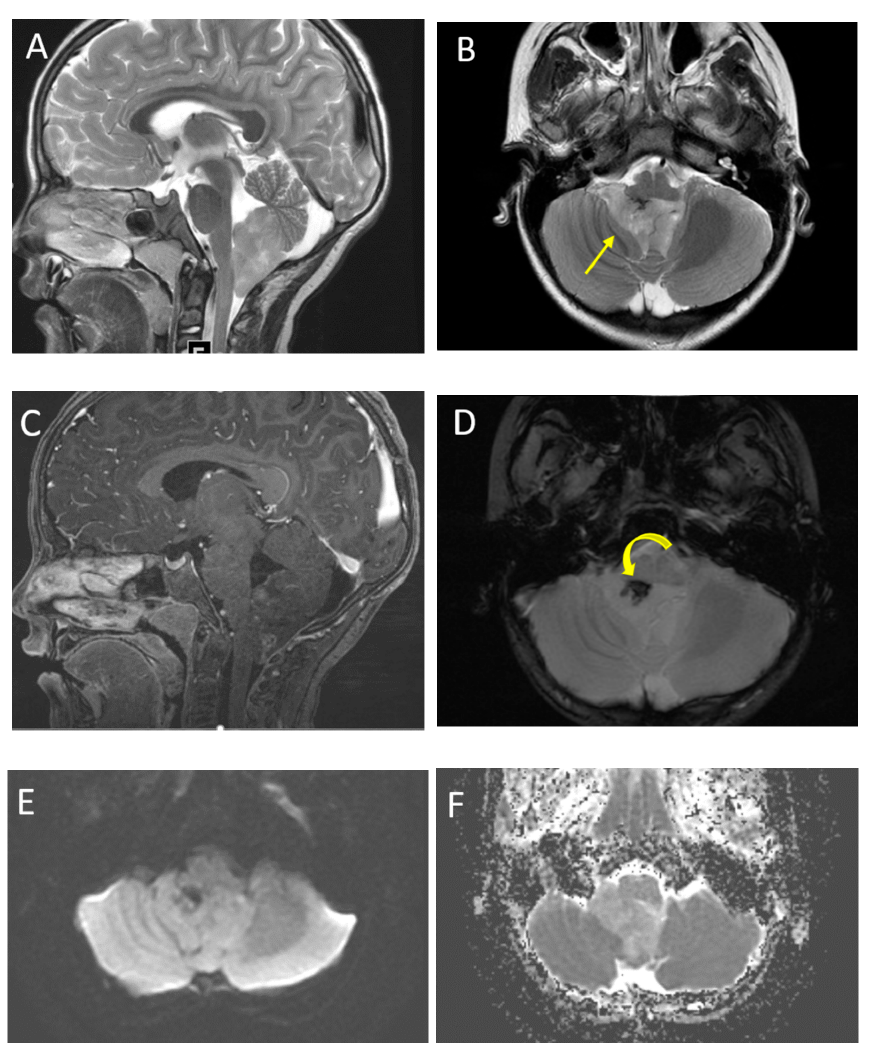
Figure 9. A 6-year-old male with ependymoma. Sagittal and axial T2 images ( A , B ) demonstrate a heterogeneous lesion involving the fourth ventricle. Note the characteristic extension through the foramen of Luska (arrow). Post-contrast T1 imaging ( C ) demonstrates typical heterogeneous en- hancement. SWI imaging ( D ) demonstrates a focus of low signal correlating with calcification (curved arrow). DWI ( E ) and ADC ( F ) imaging show increased ADC values of the tumor compared with adjacent parenchyma. Two molecular subgroups of posterior fossa ependymoma have been identified: pos- terior fossa A (PFA) and posterior fossa B (PFB) [3]. PFB lesions typically originate from